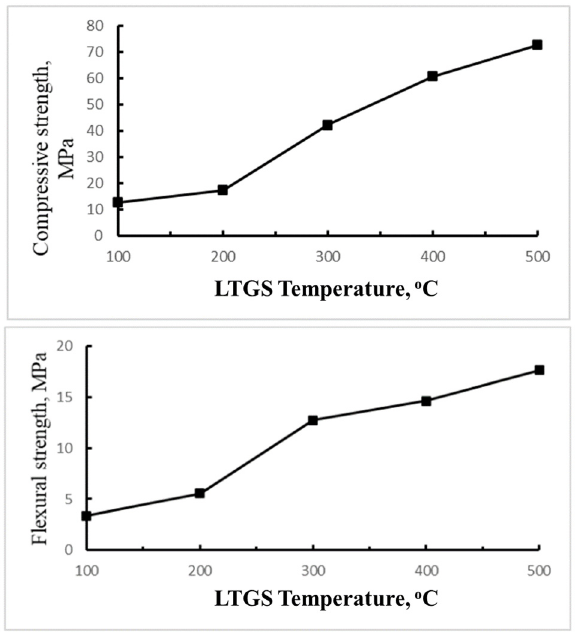
Figure 8. Effect of temperature on the mechanical strength of LTGS bricks, ( a ) compressive strength ( b ) flexural strength. Table 4. Effect of temperature on the physical properties of LTGS bricks.